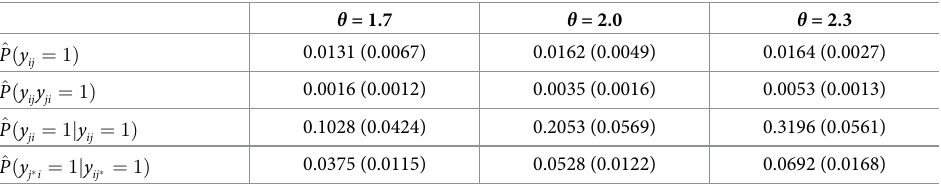
Table 1. Mean (sd) of the empirical link probabilities for the simulation data. θ = 1.7 θ = 2.0 θ =